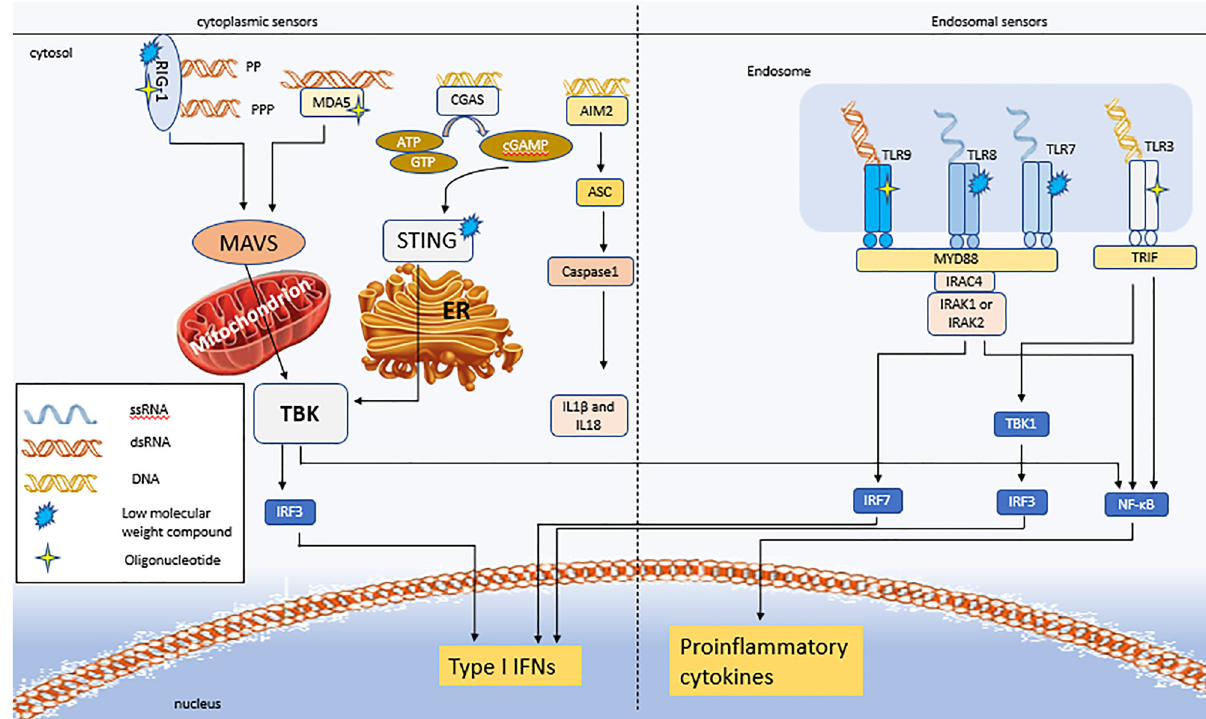
Figure 1: Cytosolic and endosomal nucleic acid-sensing